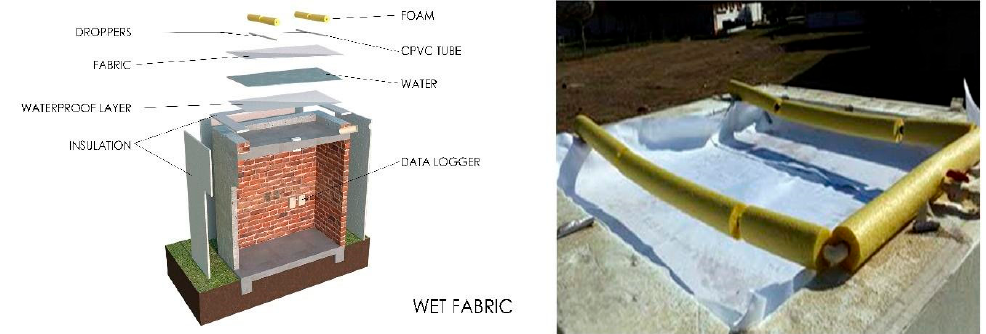
Figure 8. Cross section diagram of the wet fabric cell with its constructive characteristics.